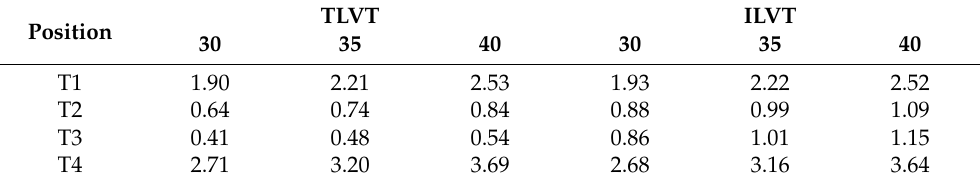
Table 9. Stress value at No. 8 loading point under lateral and vertical coupled load (MPa).